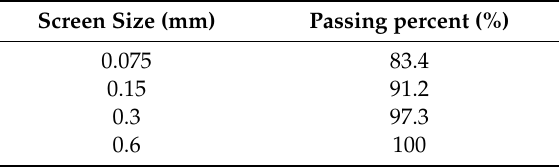
Table 5. Sieve analysis of the mineral